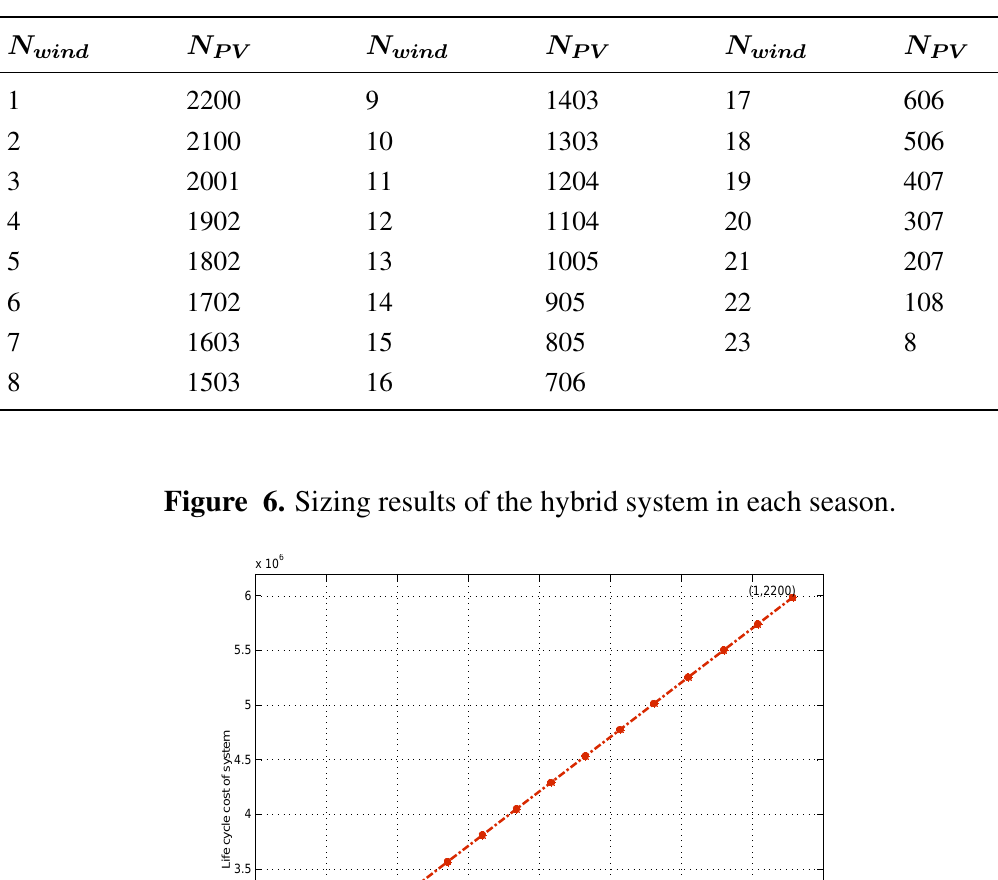
Table 3. Numbers of wind turbines and PV arrays.